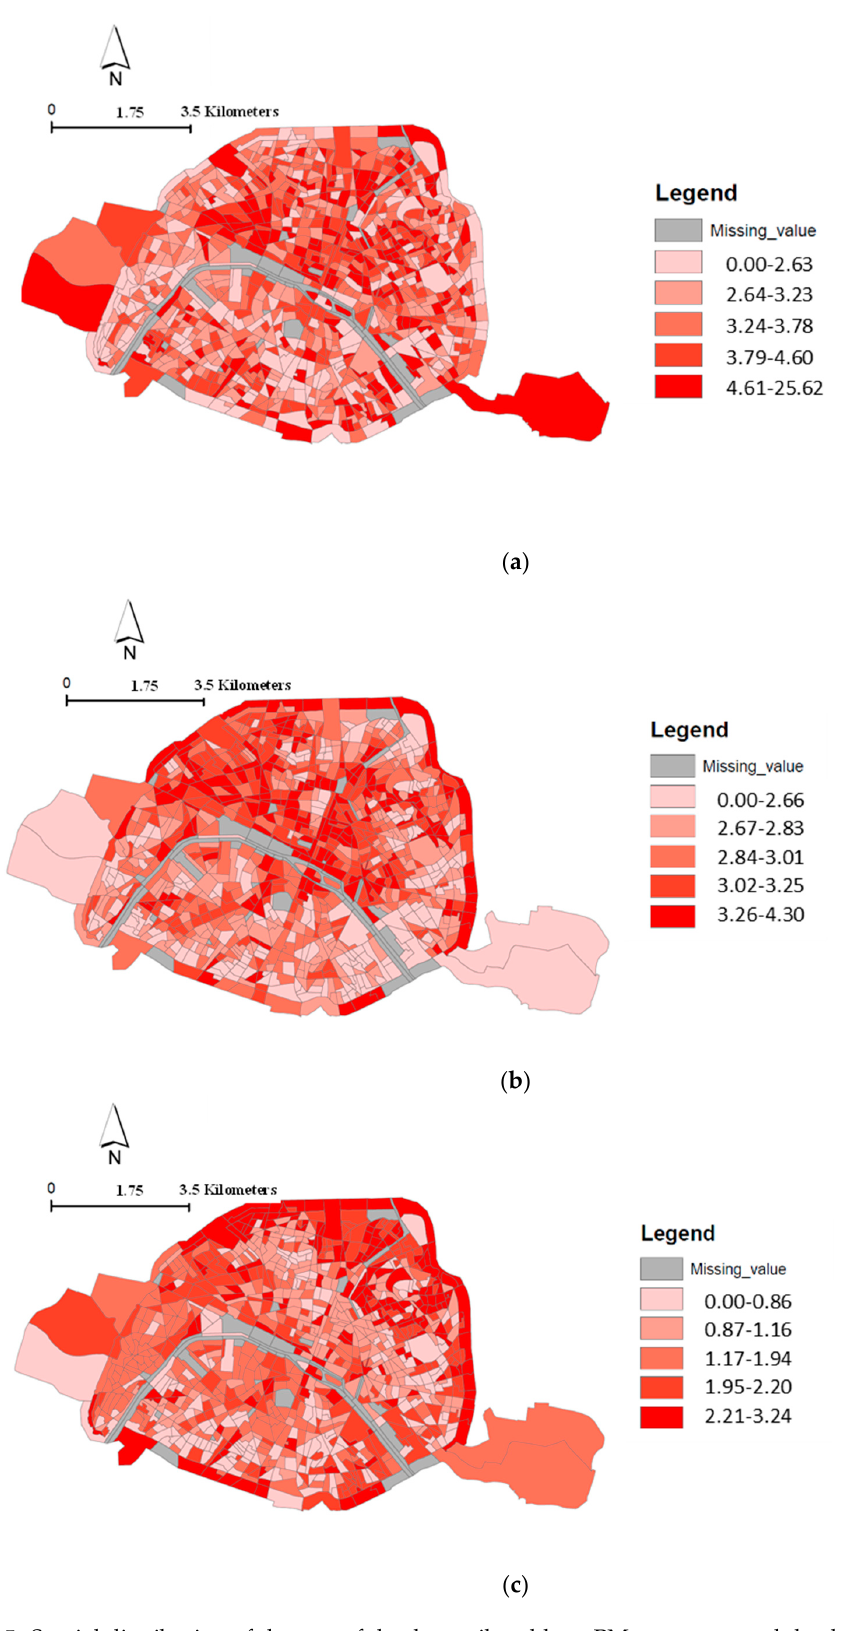
Figure A5. Spatial distribution of the rate of deaths attributable to PM 2.5 among total death, at the census block level, Paris City; ( a ) without spatial variability of PM 2.5 exposure in Paris; ( b ) with spatial variability of PM 2.5 between census block; ( c ) tacking account the spatial variability of PM 2.5 and socio-economic level between census